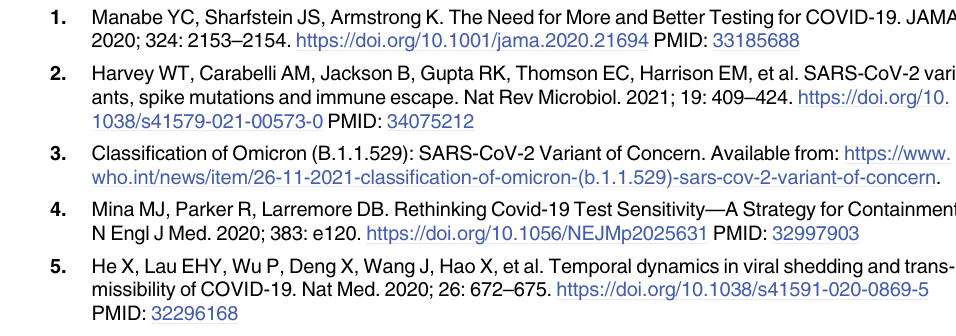
S5 Fig. ACTB detection using the direct RT-LAMP method without RNA extraction (related to Fig 5). (A) Distribution of ACTB TTRs of raw clinical NP samples under the indi- cated RT-LAMP conditions. (B) Distribution of ACTB TTRs between RT-LAMP test positive and negative from contrived raw positive NP samples. (TIF) S6 Fig. Optimization of SYTO 9 concentration for direct RT-LAMP with FluoroPLUM (related to Fig 7). RT-LAMP for ACTB was performed with 10 clinical NP samples with the indicated SYTO 9 concentrations. Bars represented the mean slope used to assess differences in the means. � , P < 0.05; �� , P < 0.01.